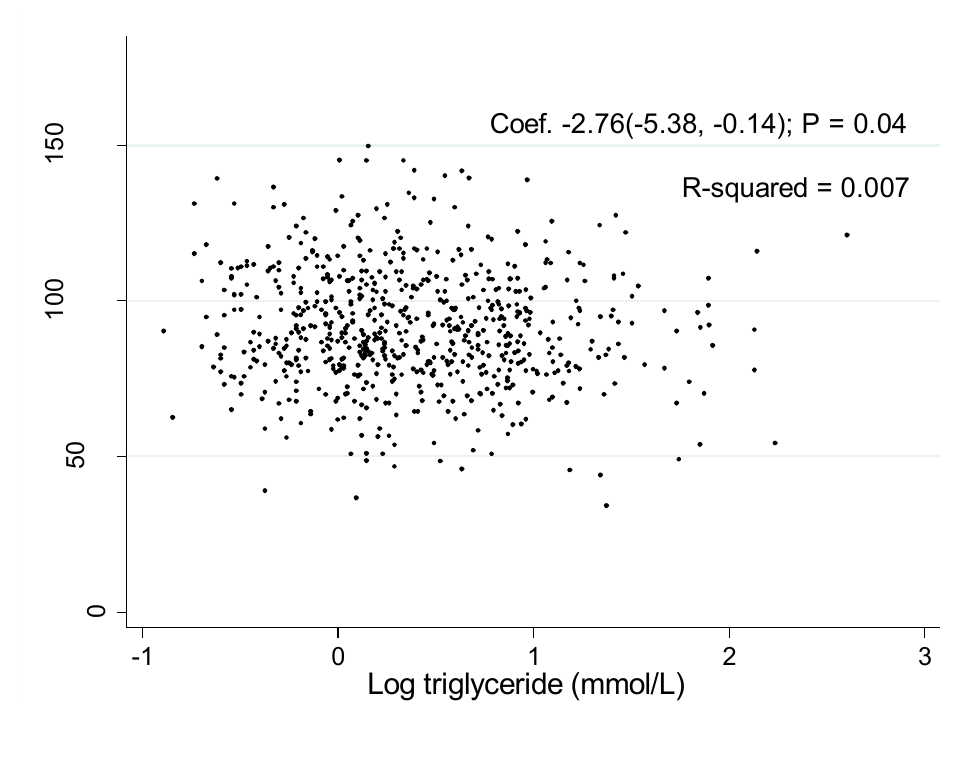
Figure 1. Association of estimated glomerular filtration rate with log triglyceride in men.